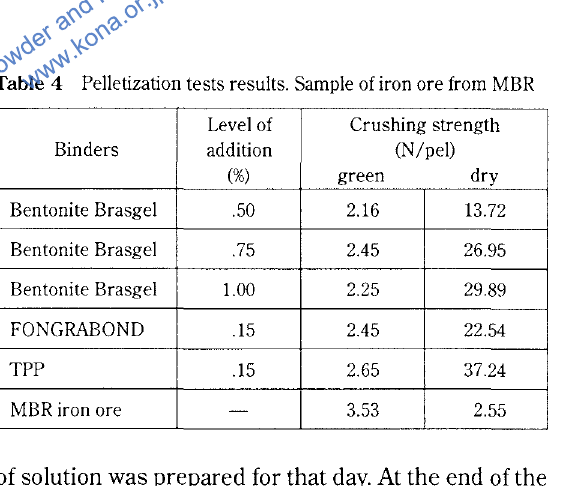
Table 4 Pelletization tests results. Sample of iron ore from MBR Level of Crushing strength Binders addition (N/pel) (%) green dry